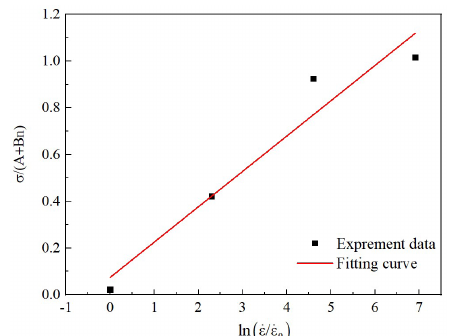
Figure 4. Determination of C -value.